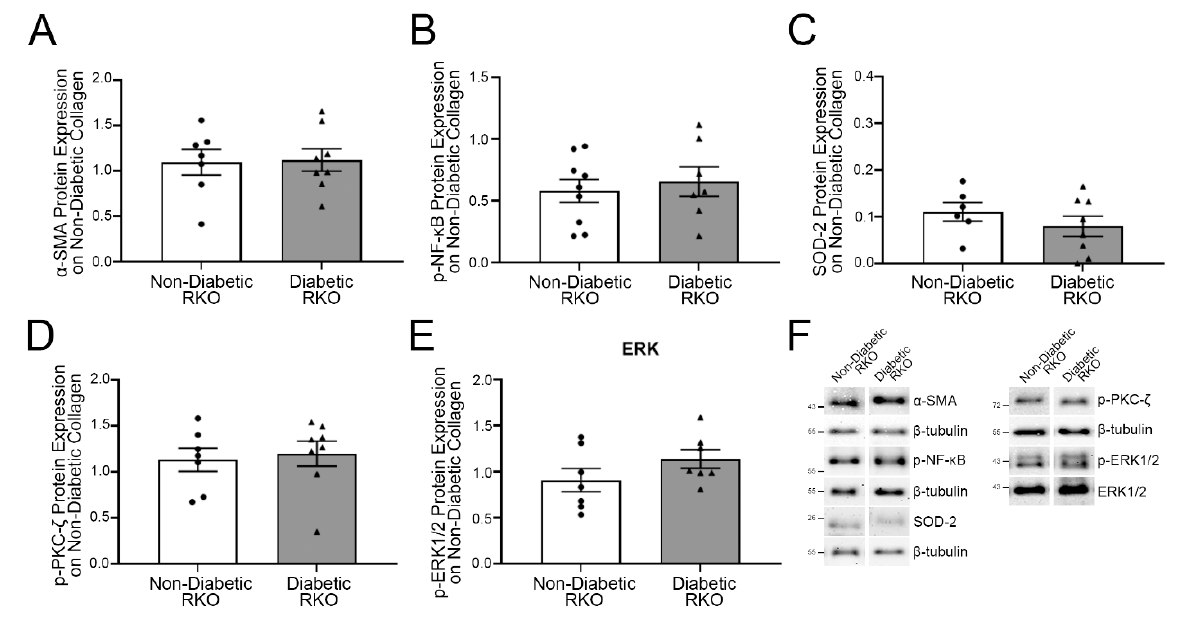
Figure 2. On non-diabetic collagen, RAGE-associated cascade signal proteins in diabetic RKO fibroblasts did not differ from non-diabetic RKO fibroblasts. Cardiac fibroblasts (P1) isolated from non-diabetic and diabetic RKO mice were cultured on collagen isolated from non-diabetic mice. Total protein was collected and used to evaluate the expression of AGE/RAGE pathway proteins involved with the signaling cascade and downstream outcomes: ( A ) α -SMA (42 kDa), ( B ) p-NF- κ B (65 kDa), ( C ) SOD-2 (25 kDa), ( D ) p-PKC- ζ (72 kDa), and ( E ) p-ERK1/2 (44 and 42 kDa, respectively). ( F ) Representative Western blot images for α -SMA, p-NF- κ B, SOD-2, p-PKC- ζ , and p-ERK1/2 are shown and are not displayed as continuous blots due to logistical constraints brought on by the number of treatment groups and genotypes. The original Western blot images are available at doi:10.6084/m9.figshare.13369535. Protein expression for α -SMA, p-NF- κ B, SOD-2, and p-PKC- ζ was normalized to β -tubulin (55 kDa) and p-ERK1/2 was normalized to total ERK1/2 protein expression. Mean ± SEM are presented in the graphs ( n = 6–9) and statistical differences were determined using a Student’s t -test.